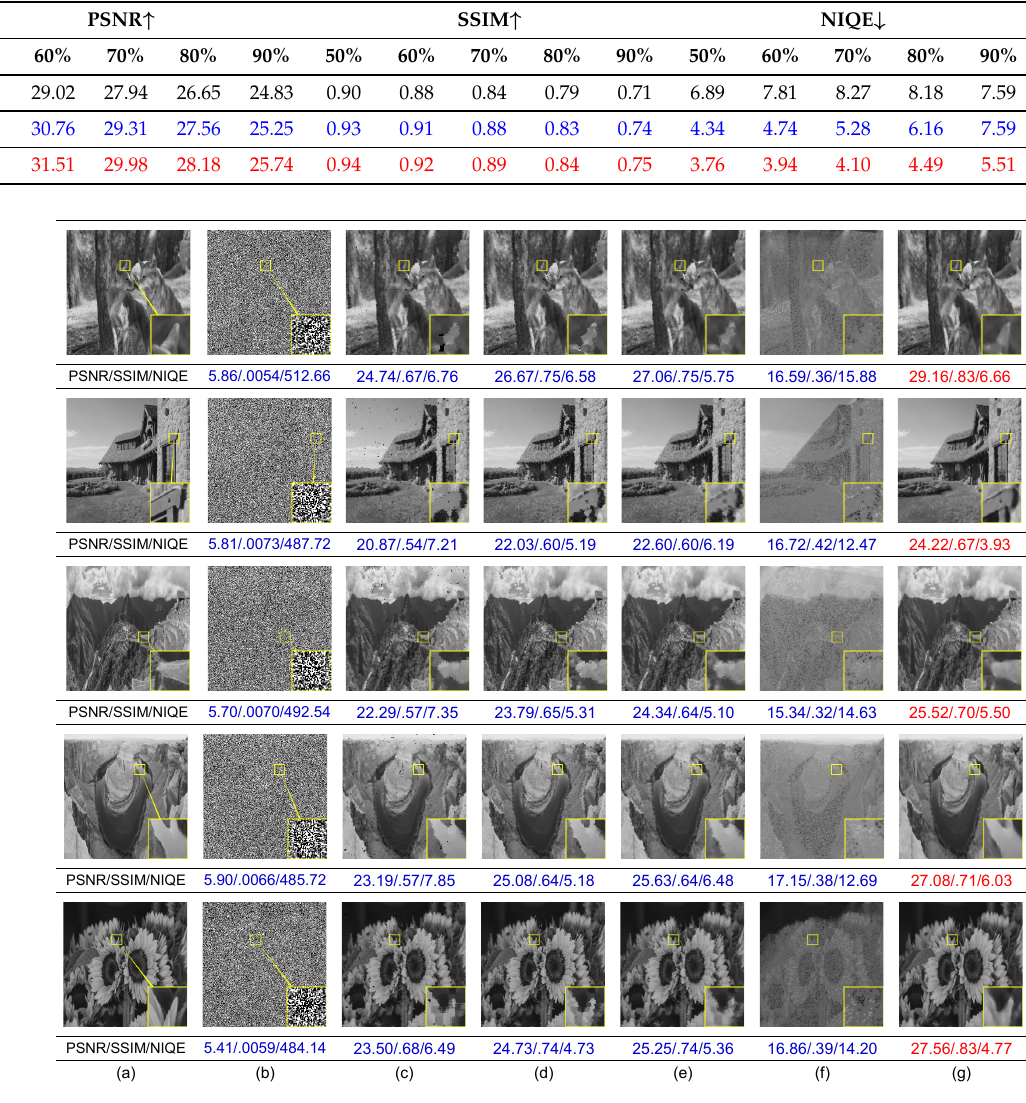
Figure 6. More examples of denoising results for images with 90% noise added using different methods. We show the corresponding objective scores below the measured images. The best scores are in red. ( a ) Original image. ( b ) Noisy images. Denoising results using ( c ) MDBUTMF